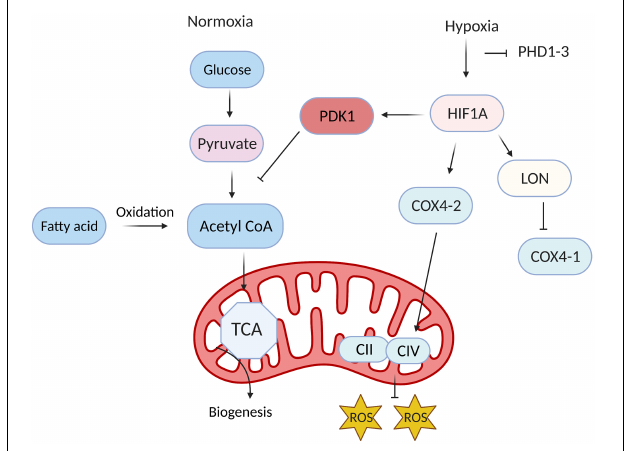
FIGURE 3 | Hypoxia-inducible factor (HIF) reinforces glycolytic metabolism in endothelial cells (ECs). Under normoxic conditions, only a small proportion of the products of glycolysis in ECs are converted into acetyl CoA and enter the TCA cycle; instead, most of the acetyl-CoA is generated via fatty-acid metabolism and used for biomass production. During hypoxia, HIF reinforces the dependence of ECs on glycolysis by inducing the expression of PDK1, which prevents the conversion of pyruvate to